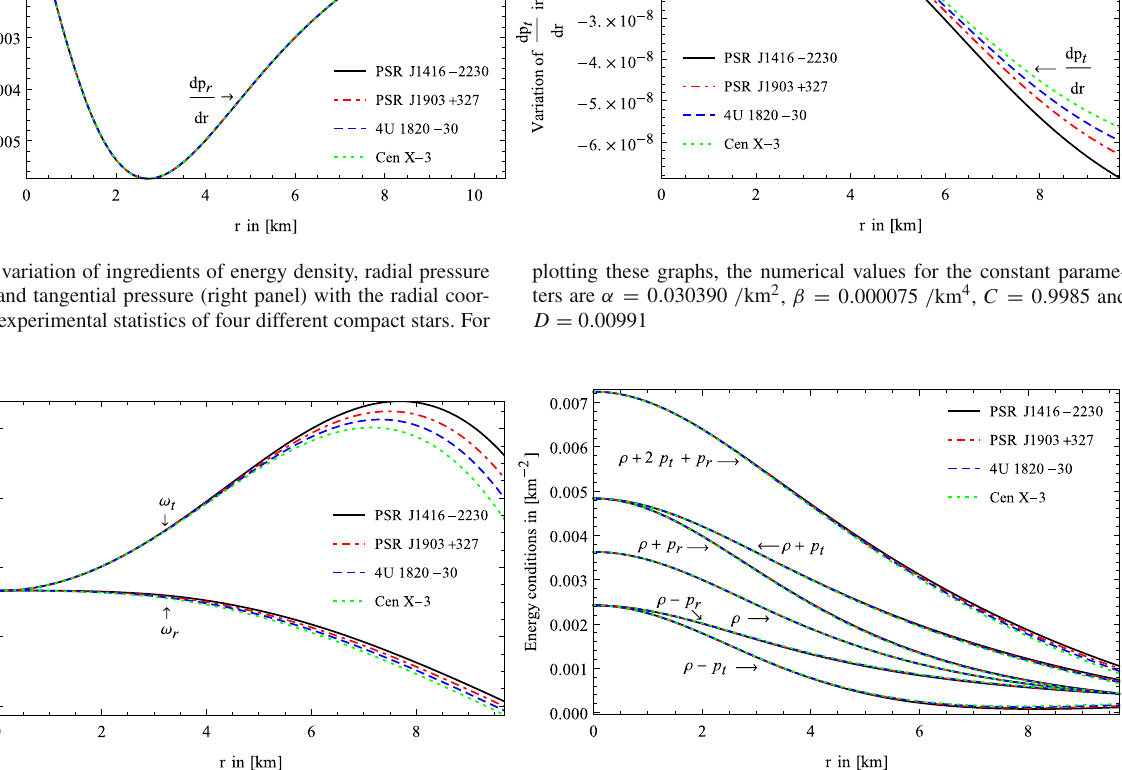
ting these graphs, the numerical values for the constant parameters are α = 0 . 030390 / km 2 , β = 0 . 000075 / km 4 , C = 0 . 9985 and D = 0 . 00991